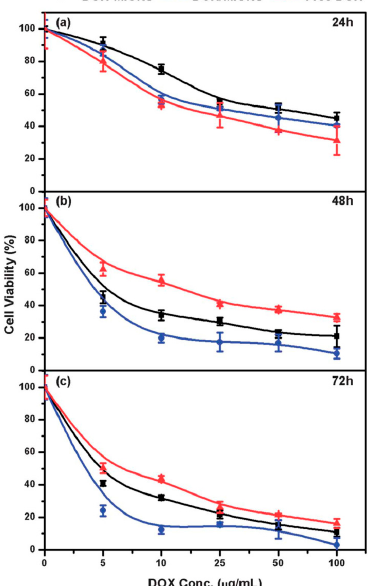
Figure 10. Viability of cells (HepG2) after ( a ) 24 h; ( b ) 48 h; and ( c ) 72 h incubation with DOX–MIONs, DOX/MIONs, and free DOX having equivalent concentration of DOX